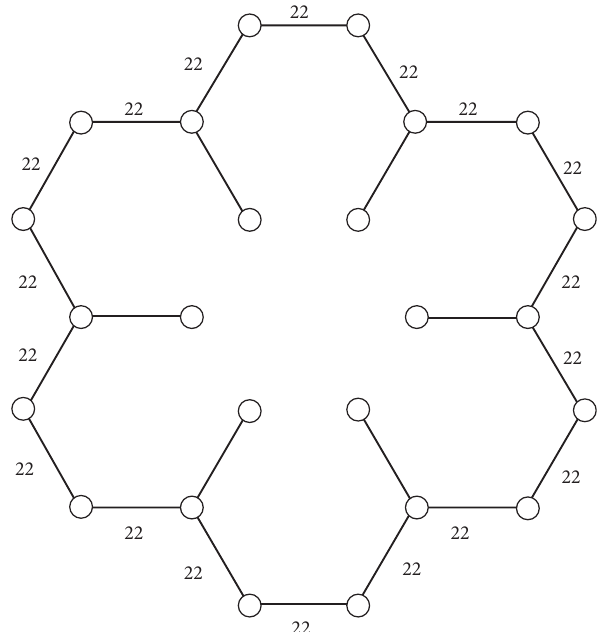
Figure 10: The labels of all edges of the outer cycle C